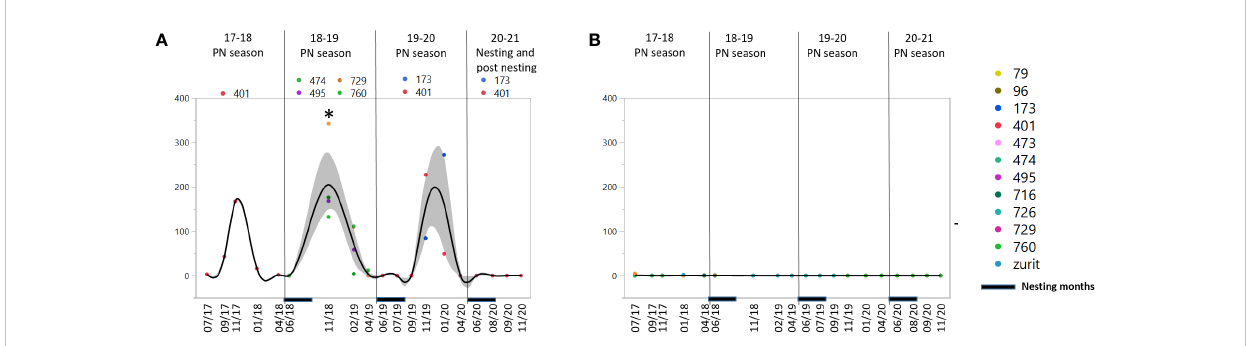
FIGURE 4 Concentration measurements of gamma-glutamyl transferase (GGT) in female green turtles, (A) Future nesters (FN) and (B) Non nesters (NN). Measurements are represented for 19 sampling dates in the period of 2017-2020 divided to 3 pre-nesting (PN) seasons – 17-18, 18-19 and 19-20 and the last nesting/posting season, the nesting period marked at the X axis. At the left panels, asterisk represents signi fi cant difference between the two groups p= 0.05. Shaded area represent the con fi dence of fi